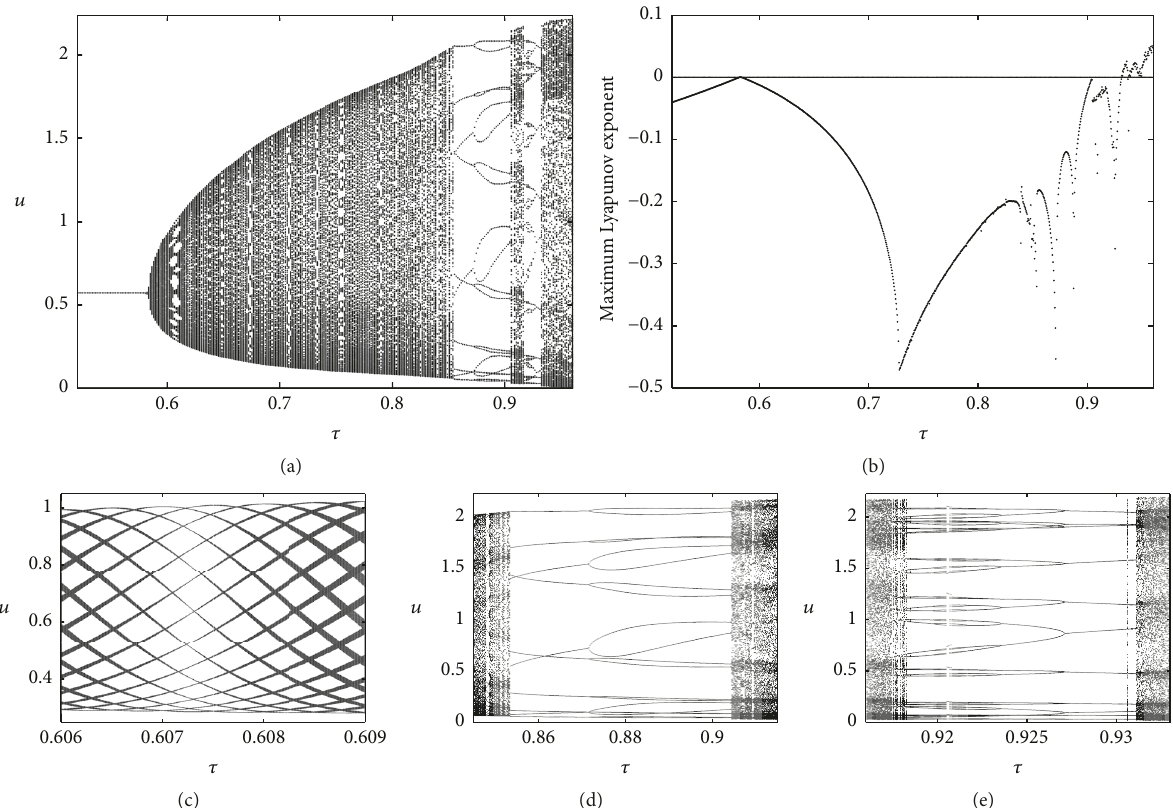
Figure 9: (a) Neimark-Sacker bifurcation diagram with parameter values given as 𝑎 = 2 , 𝑏 = 4 , 𝑐 = 1 , 𝑑 = 2.2 , 𝛼 = 0.05 , and 𝛽 = 0.5 ; (b) maximum Lyapunov exponent corresponding to (a); (c)–(e) local amplifications of (a) in the range of [0.52, 0.96]